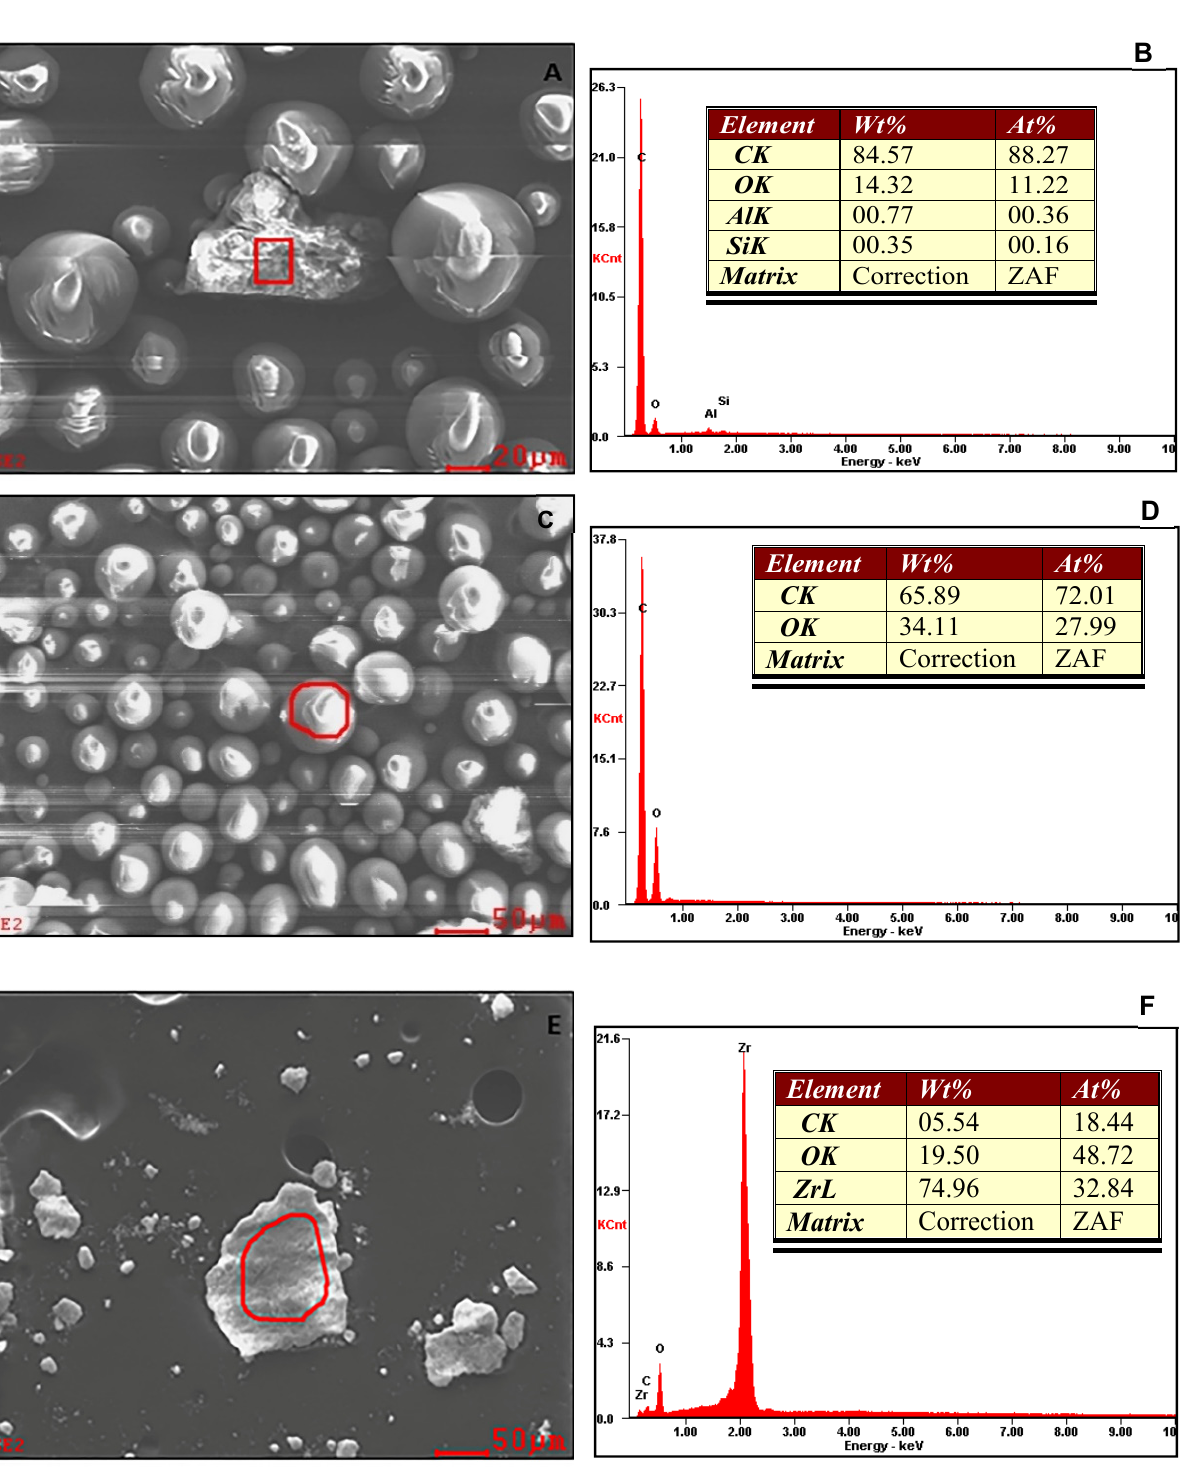
Figure 2. SEM images and EDX spectra representing ( A , B ) rubber particles in PMMA powder, ( C , D ) PMMA particles and ( E,F ) zirconia nanoparticles.